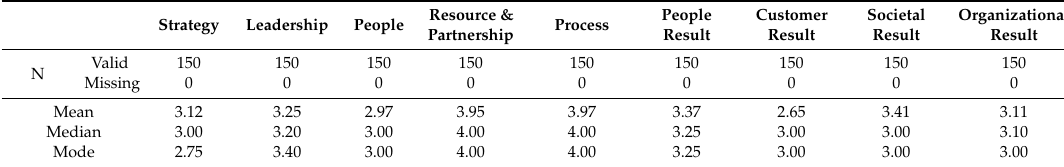
Table 1. Response statistics of the questionnaire ( n =